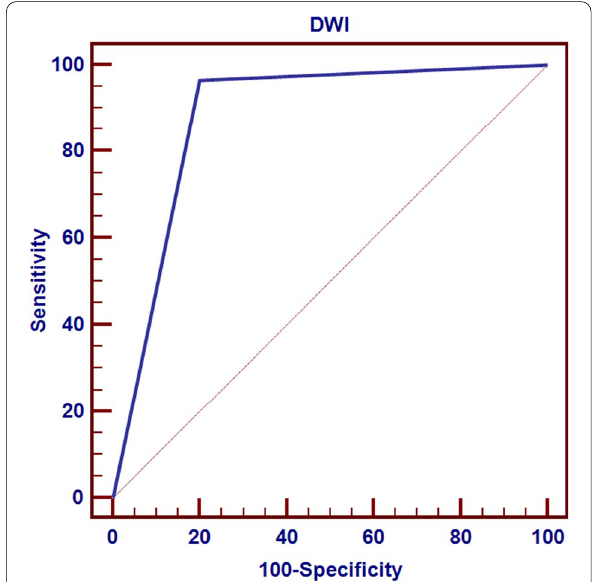
Fig. 1 Diagnostic accuracy of DW-MRI in discrimination between malignant and benign axillary lymph